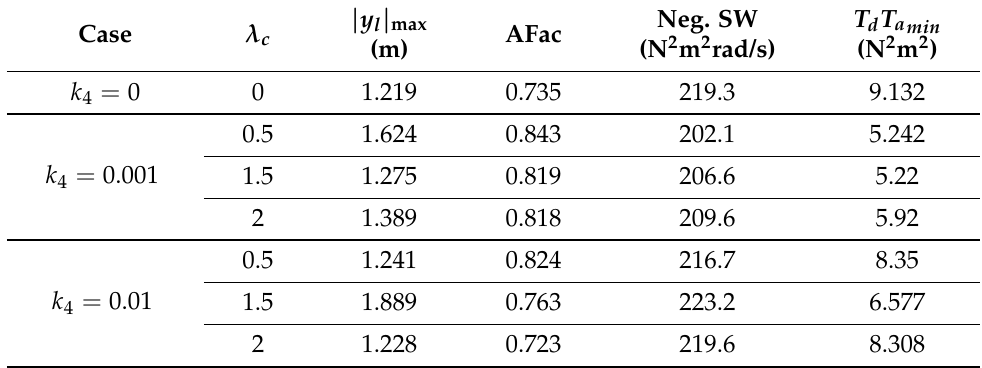
Table 1. Influence of k 4 and λ c on